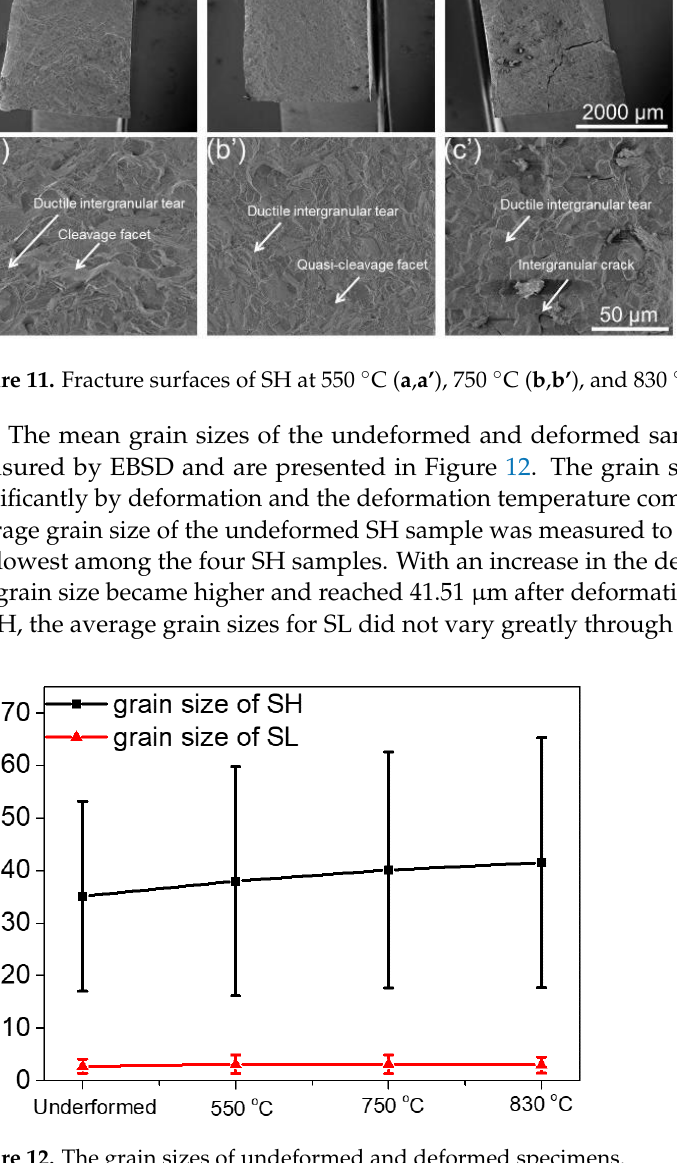
Figure 12. The grain sizes of undeformed and deformed specimens.